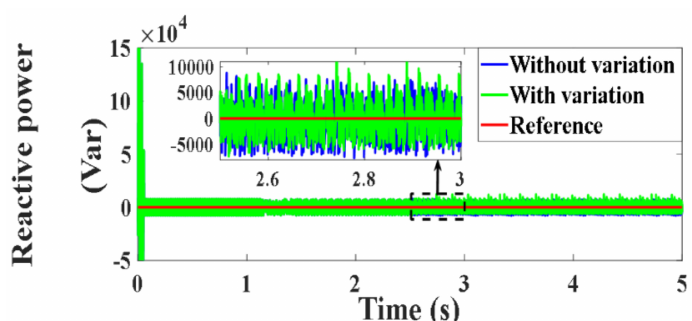
Figure 122. Reactive power under PVC (var).